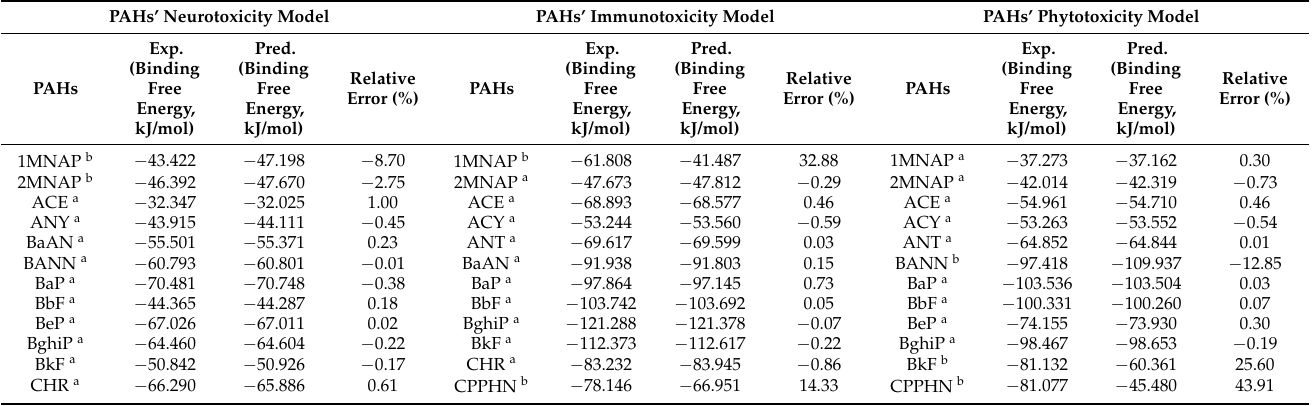
Table 3. Experimental values, predicted values and relative errors of the molecules in training set and test set of models for PAHs’ neurotoxicity, immunotoxicity, and